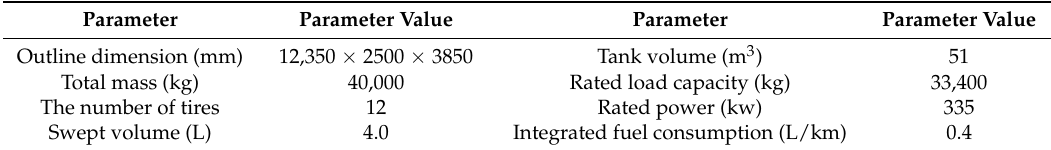
Table 4. The parameters of oil tank truck.